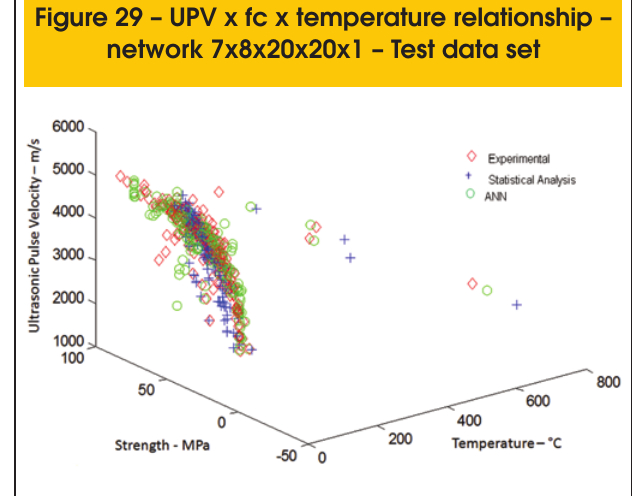
Figure 28 – UPV x fc x temperature relationship – network 7x8x20x20x1 – Training data set